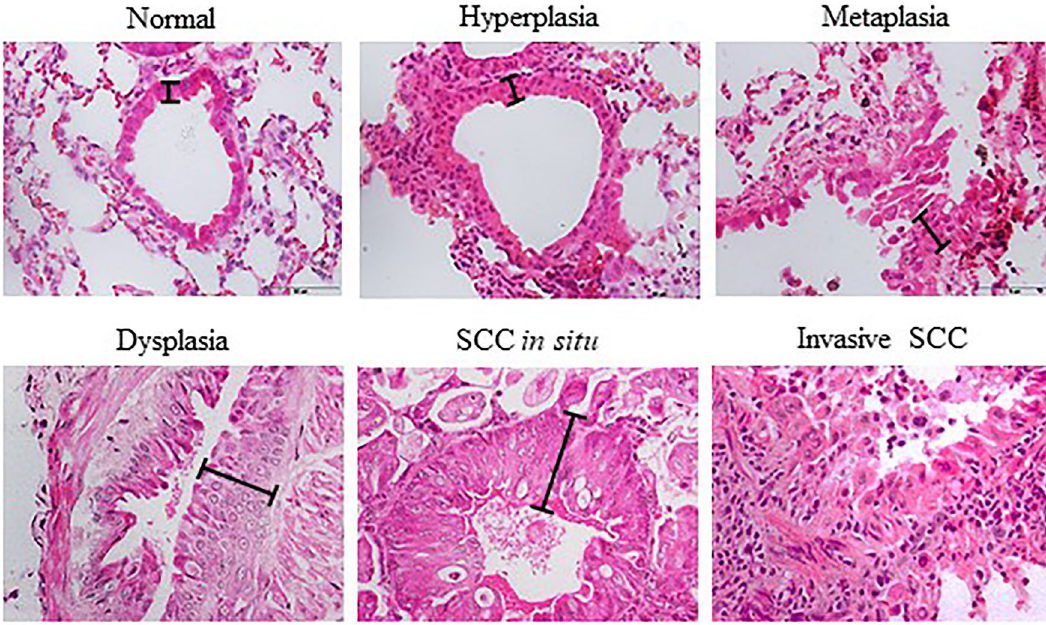
Figure 3. NTCU induces lung SCC through ‘normal-hyperplasia-metaplasia-dysplasia-SCC’ sequence in mice model. The lines show the length of epithelial cells measured for epithelium thickness